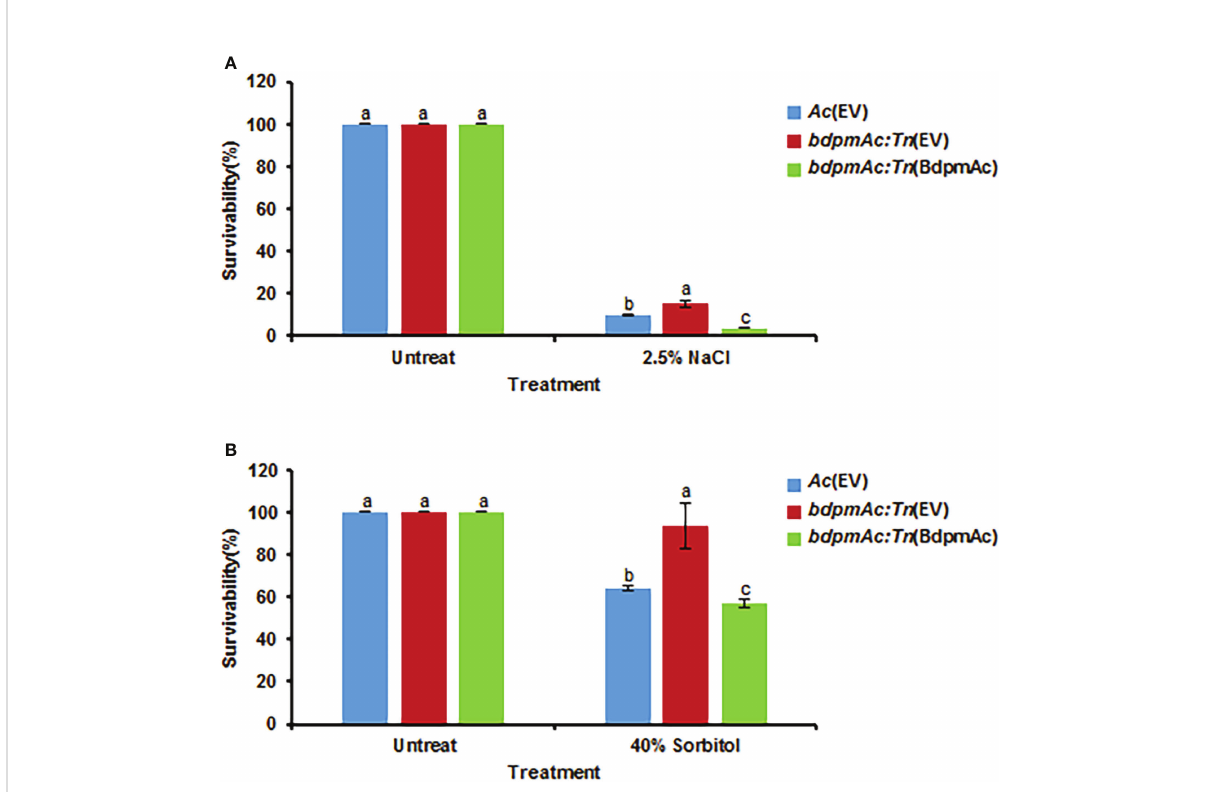
FIGURE 6 Osmotic stress tolerance. The tolerance of the Ac strains to osmotic stresses was evaluated with (A) 2.5% NaCl and (B) 40% sorbitol in TSB. Bacterial cell survival rates were evaluated via colony counting. The survival rate was calculated as the ratio of the viable cell numbers from the stress conditions to those of the untreated samples. The error bars indicate the standard error of the mean from three biological replicates with three technical replicates and different characters above the bars indicate signi fi cant differences according to ANOVA (p<0.05) with Tukey ’ s HSD Test. Seven and fi ve independent experiments were conducted for NaCl and sorbitol, respectively. All experiments showed similar